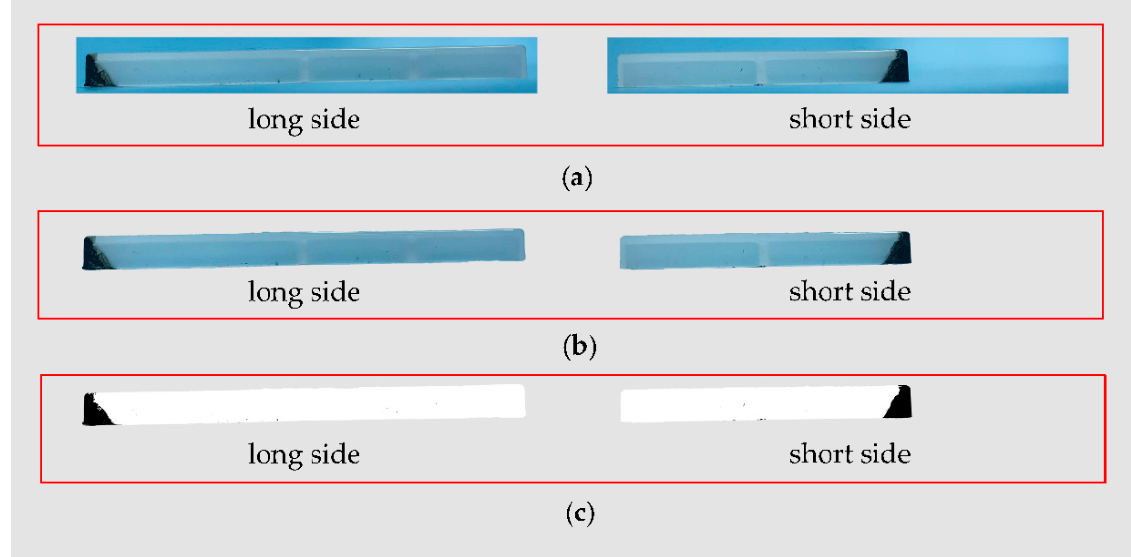
ε = 4.98% for the parts molded by CIM with the molding parameters shown in Table 1.